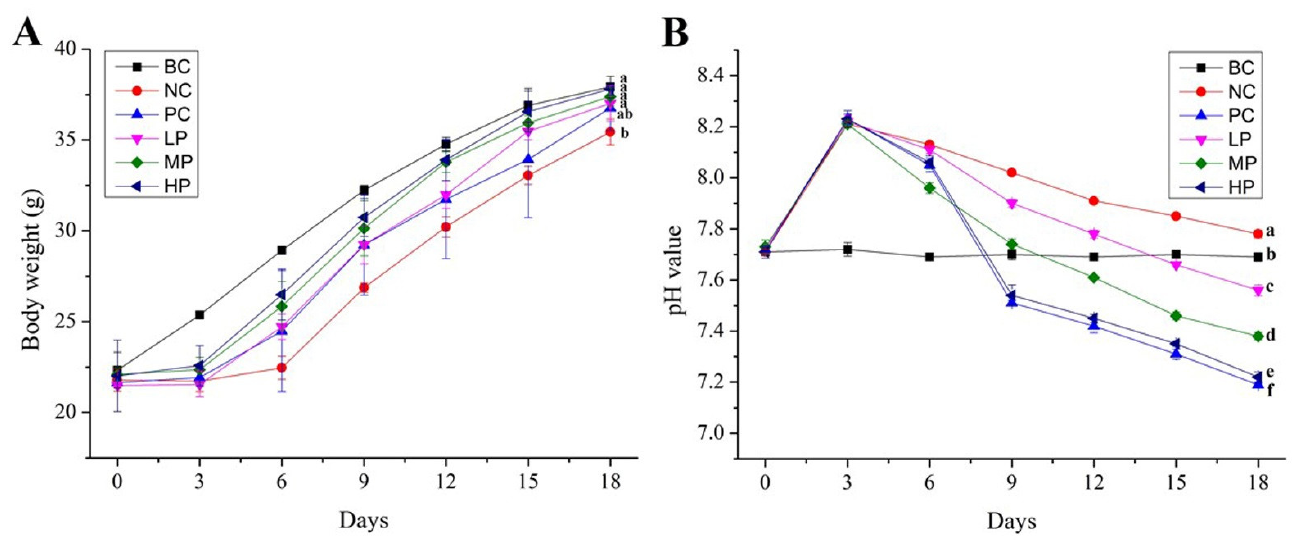
Figure 2. Effects of BSP on bodyweight of mice ( A ) and pH value of mice feces ( B ). BC (blank control) represents healthy mice; NC (negative control) represents AAD mice without treatment; PC (positive control) represents AAD mice administrated with 200 mg/kg BW of inulin; LP, MP and HP represent AAD mice administrated with low-dosage (100 mg/kg BW), middle-dosage (200 mg/kg BW) and high-dosage (400 mg/kg BW) of BSP, respectively. a–f: The results of the day 18 marked without the same letters differed significantly ( p < 0.05). The values are expressed as means ± S.D.